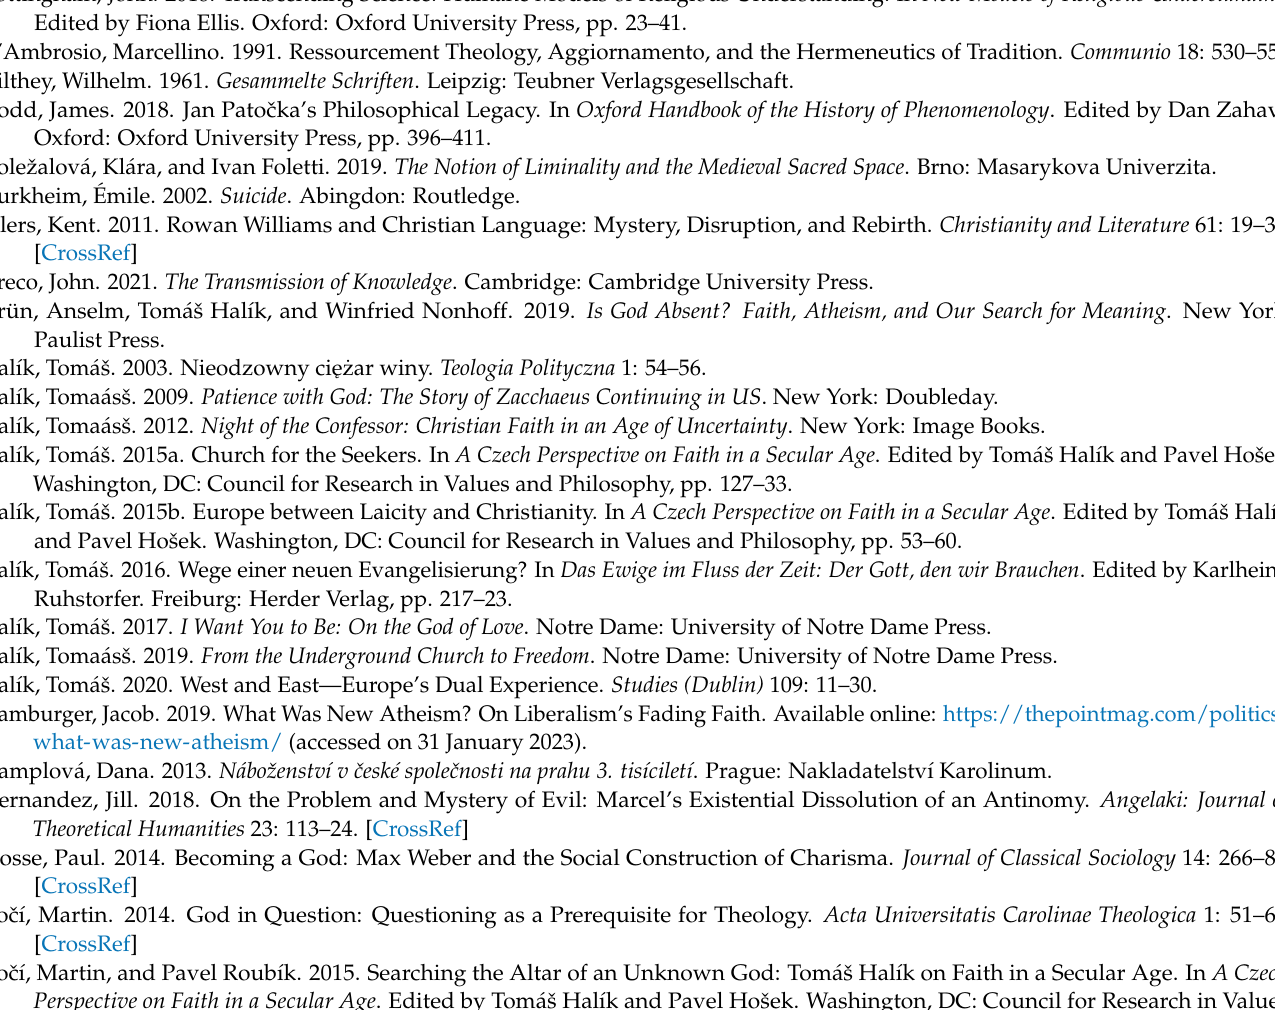
The abbreviation “GDR” refers to the former “German Democratic Republic” or “East Germany”, which became part of the Soviet Bloc in 1949, and collapsed in 1989 with the fall of the Berlin Wall. For a highly insightful critique, see Hamburger